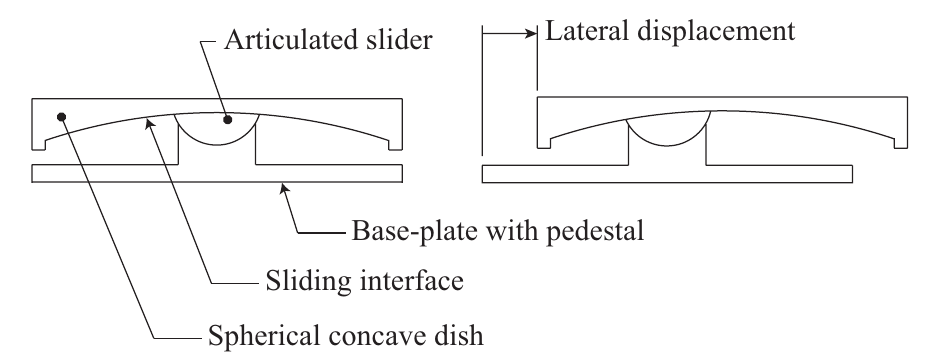
Figure 4. Illustration of Friction Pendulum TM